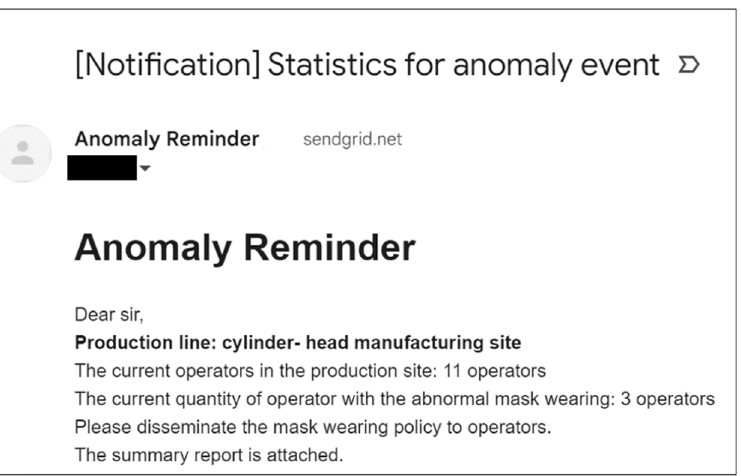
Figure 14. The result of anomaly notification via email using the SendGrid API.